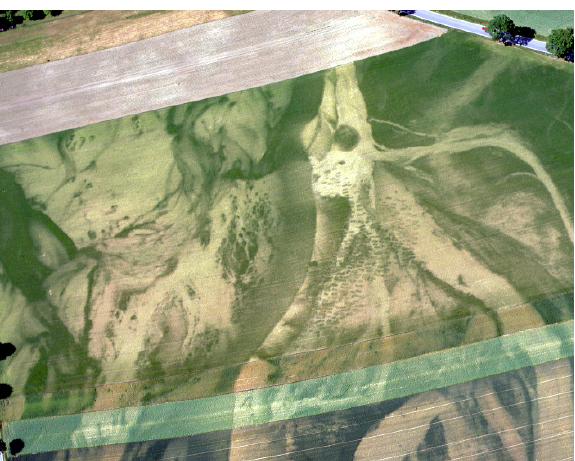
Figure 1: Vegetation marks hinting at a graveyard (right half, center) with more than 300 burials from the 8th century